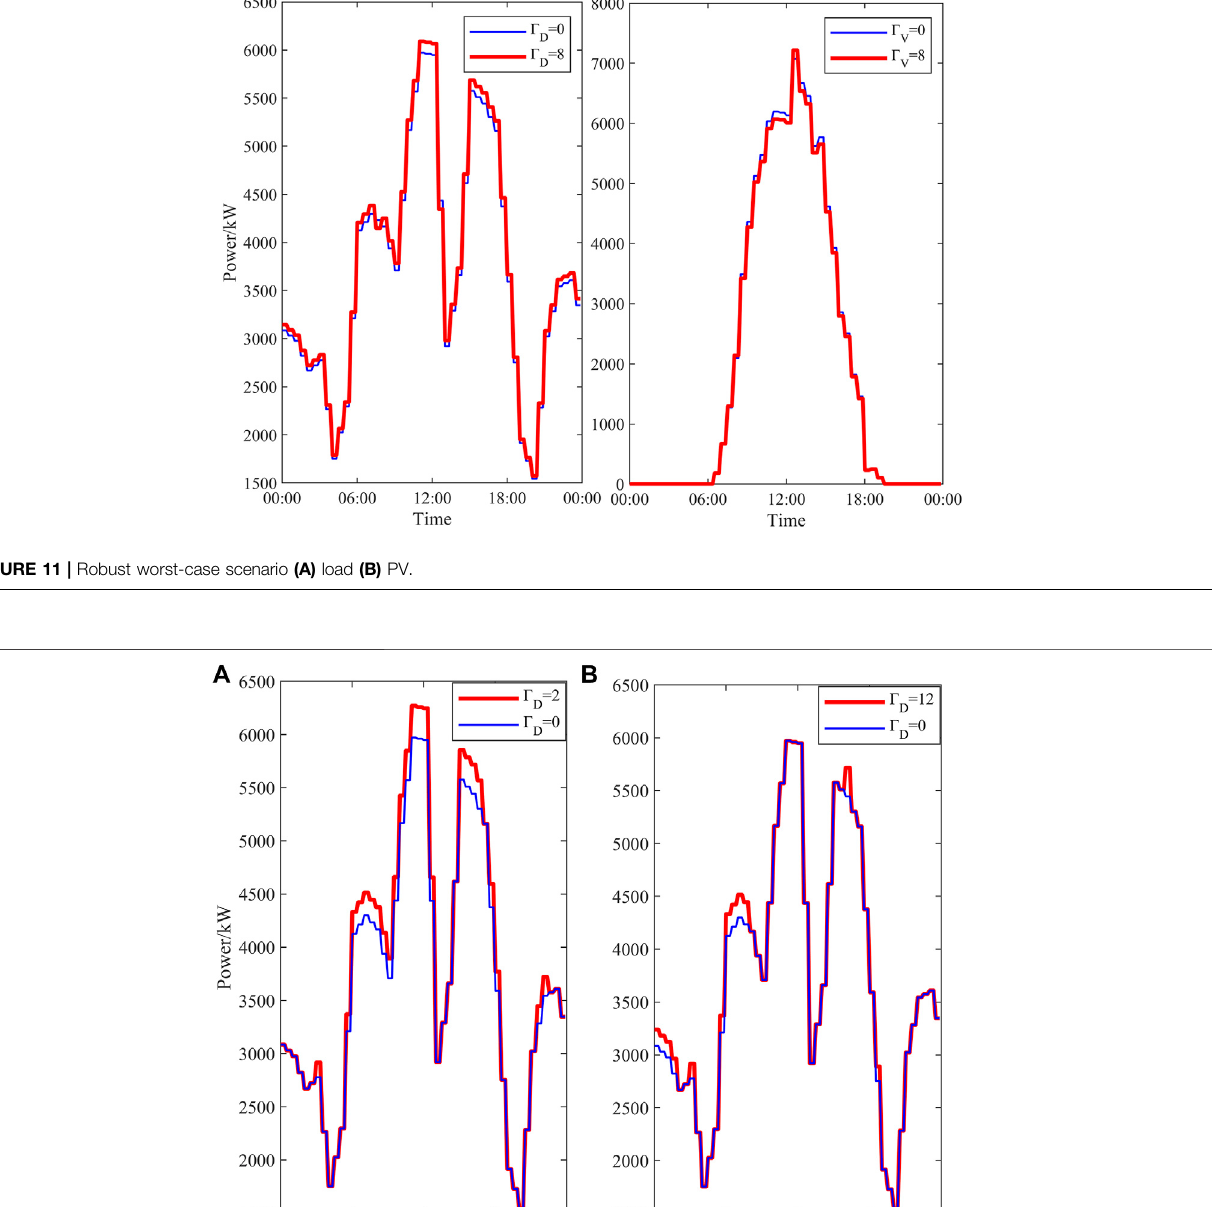
Frontiers in Energy Research |